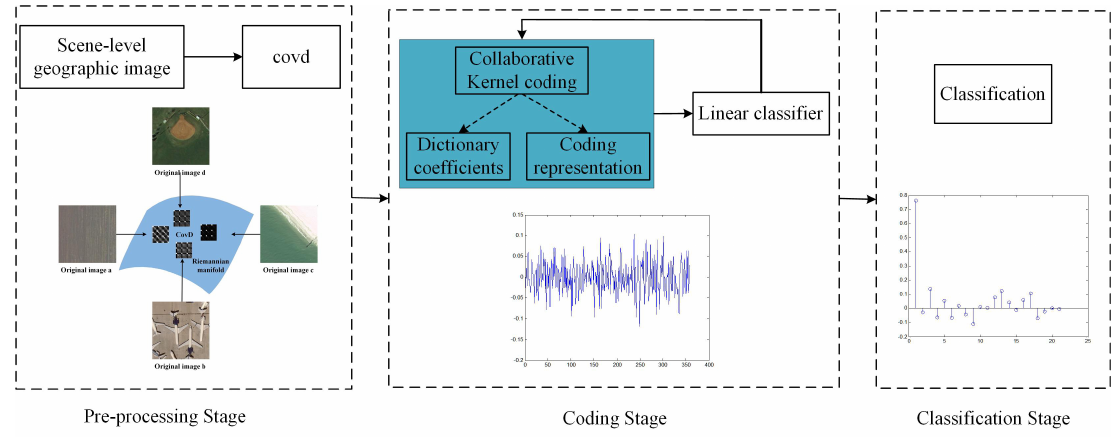
Figure 3. The overview of the proposed method. covd, covariance